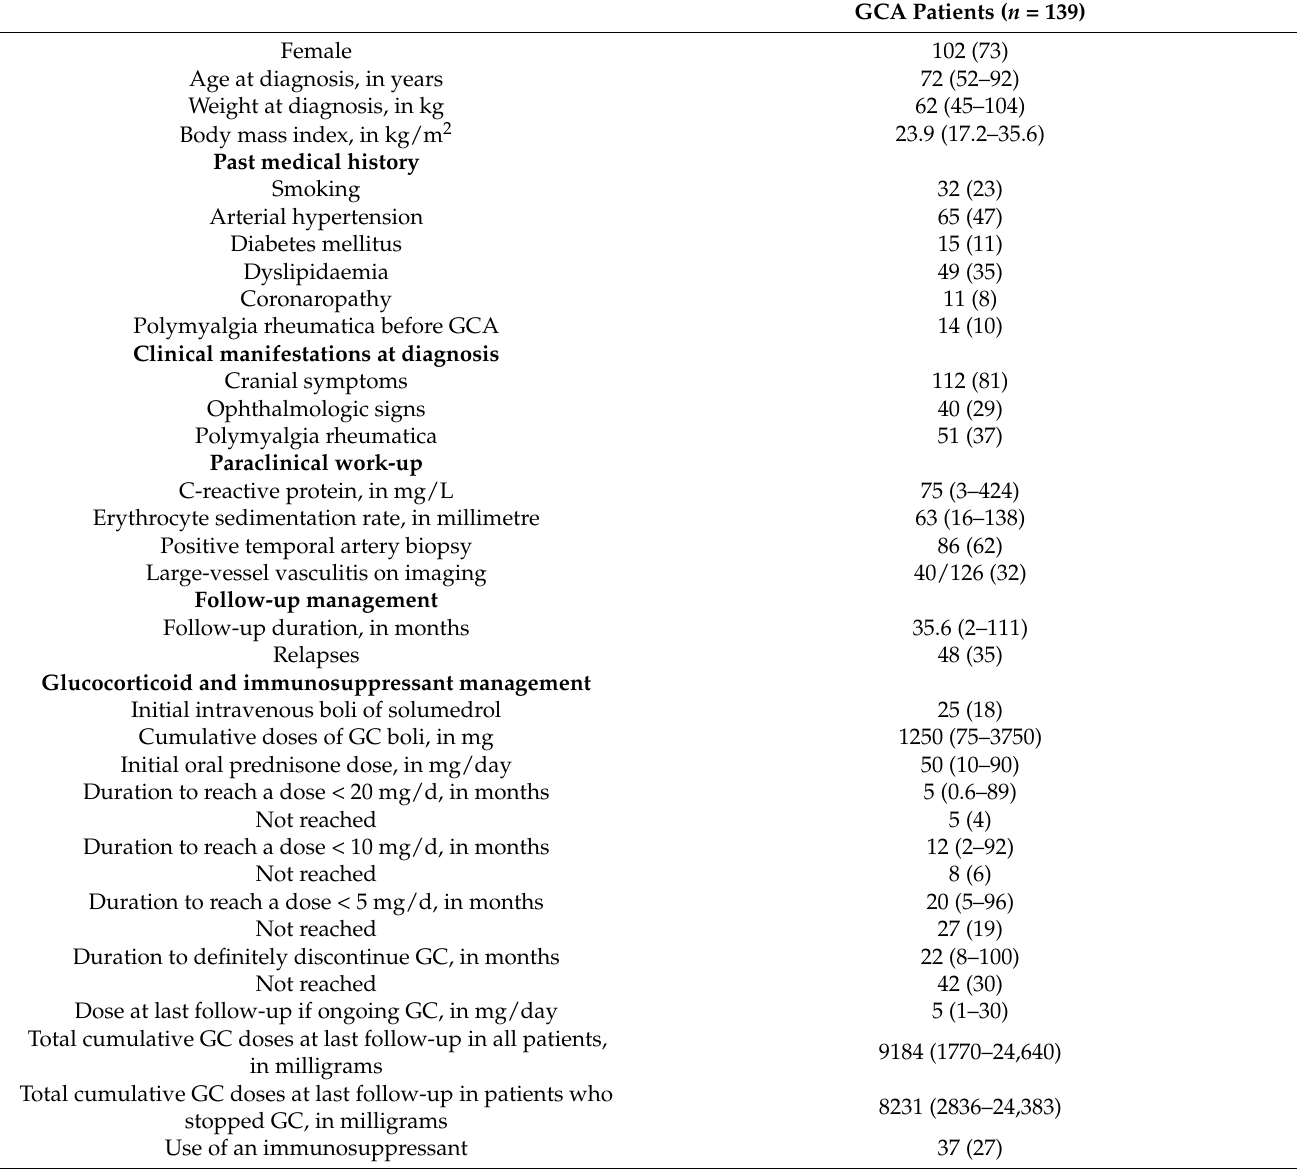
Table 1. Characteristics, treatments and outcomes of included GCA